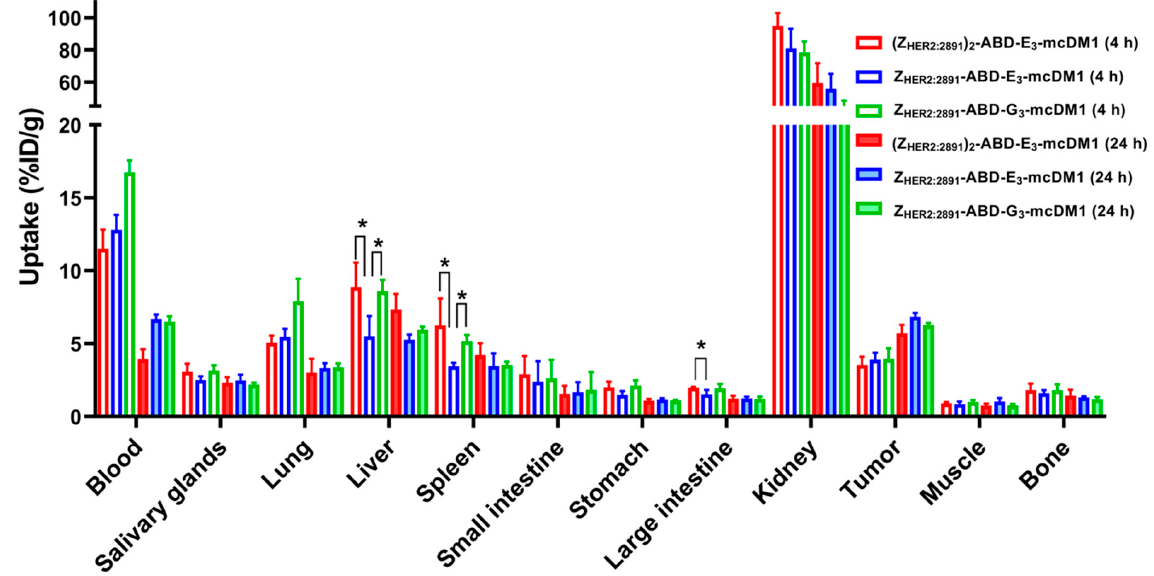
Figure 4. Biodistribution of 99m Tc-labeled AffiDCs in female BALB/c nu/nu mice with SKOV3 xenografts at 4 and 24 h after injection. The radioactivity is expressed as per cent of injected dose per gram tissue (%ID/g), and presented as an average value from 3 to 4 animals ± 1 SD. Star signs (*) correspond to significant differences ( p < 0.05).